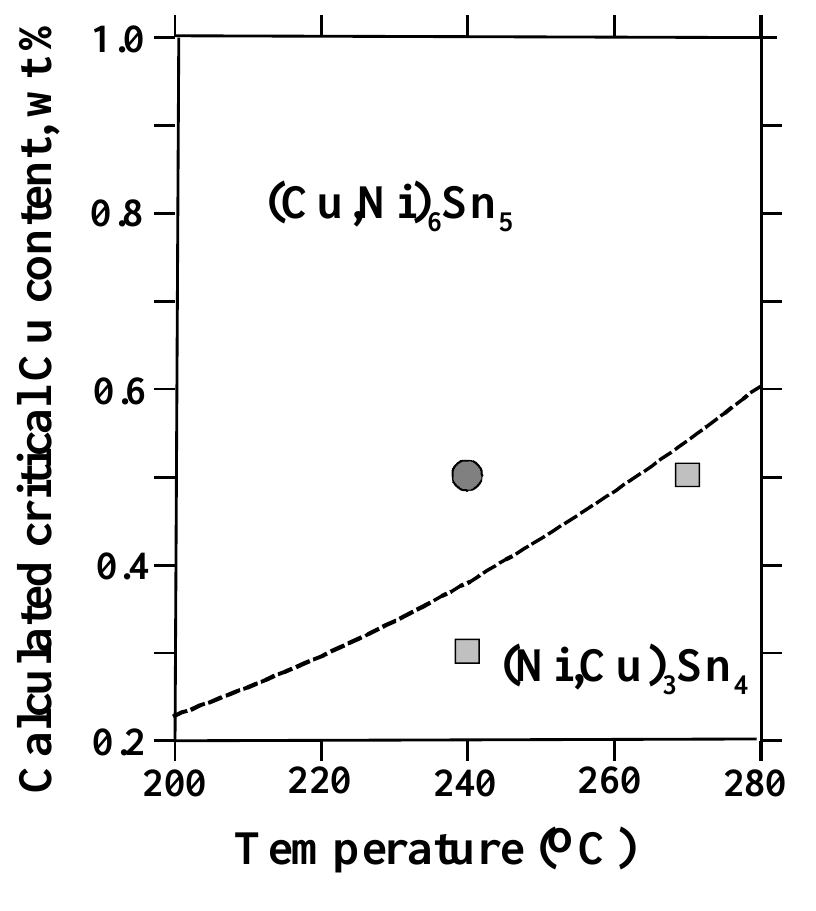
Figure 11. Calculated critical Cu content in liquid Sn to change interfacial reaction product Sn to (Cu,Ni) Sn , as a function of temperature together with the from (Ni,Cu) 3 4 6 5 experimental